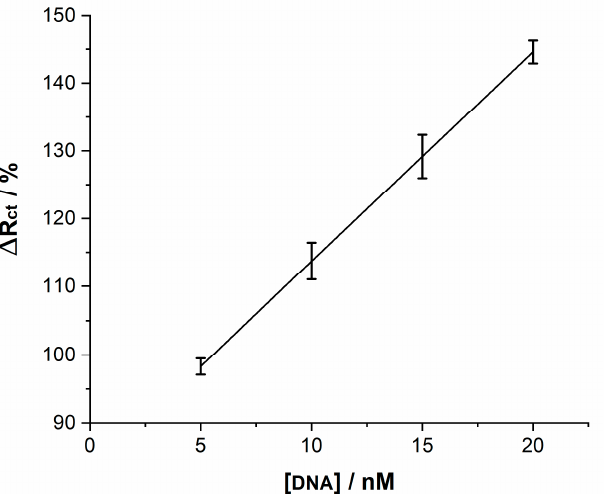
Figure 9. Sensitivity of the DNA biosensor with EIS electrochemical technique at different DNA concentrations.